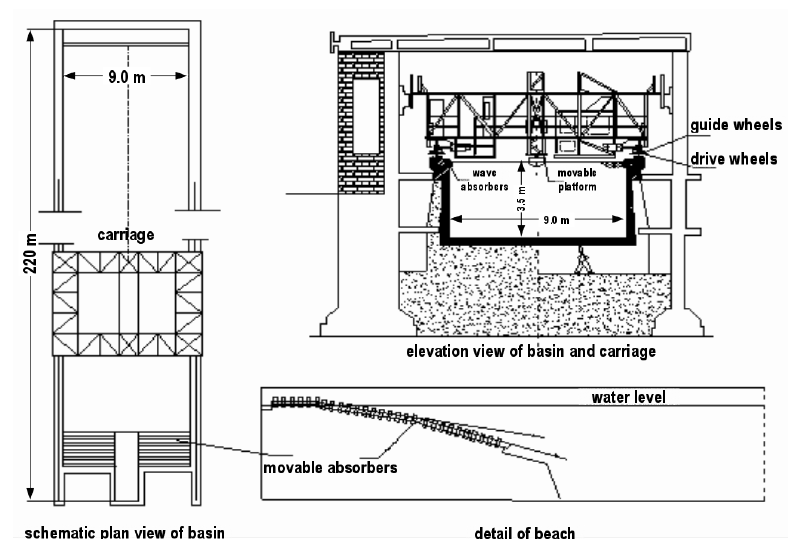
Figure 2. Schematic of the towing tank of C NR -I NM at Rome, Italy.